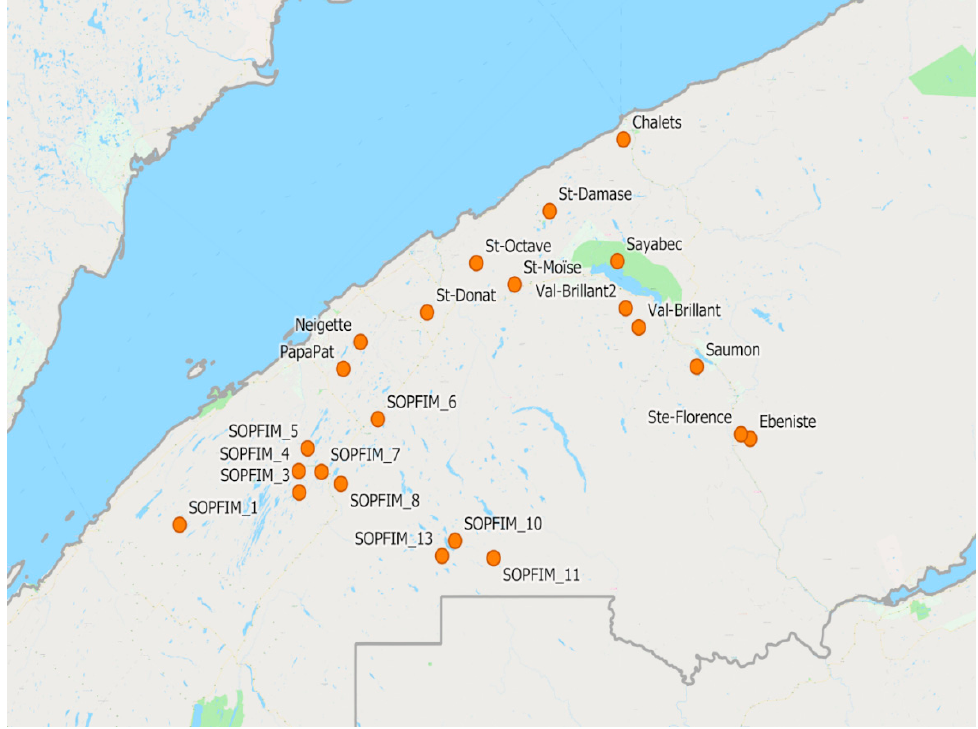
Figure 2. Map of the Lower St-Lawrence region of Quebec, with location of all plots in this study.